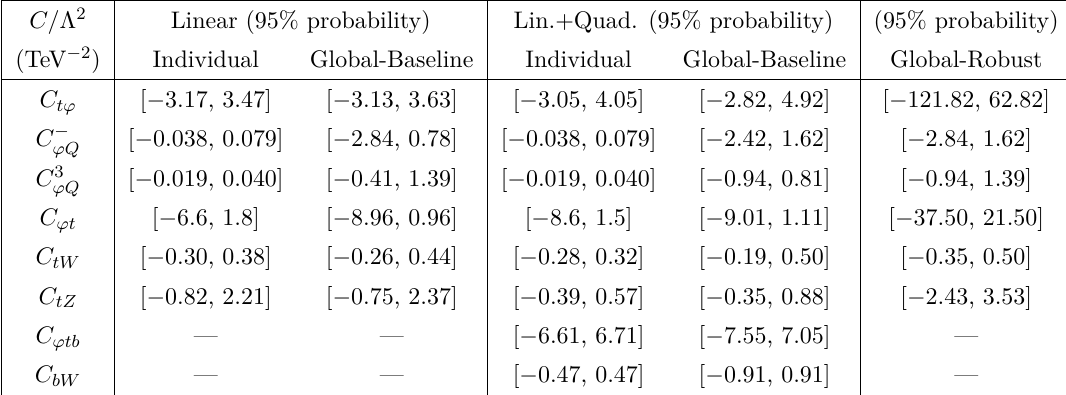
Table 2 . Allowed ranges of the Wilson coefficients with a probability of 95% expressed in TeV − 2 including only linear terms or linear and quadratic terms. We show, from left to right, the results of five fits: individual with linear terms, global baseline with linear terms, individual with linear and quadratic terms, global baseline with linear and quadratic terms and global robust limits. The robust result accounts for the effects of the correlations between the observables, the inclusion of further operators and the theoretical uncertainties on the